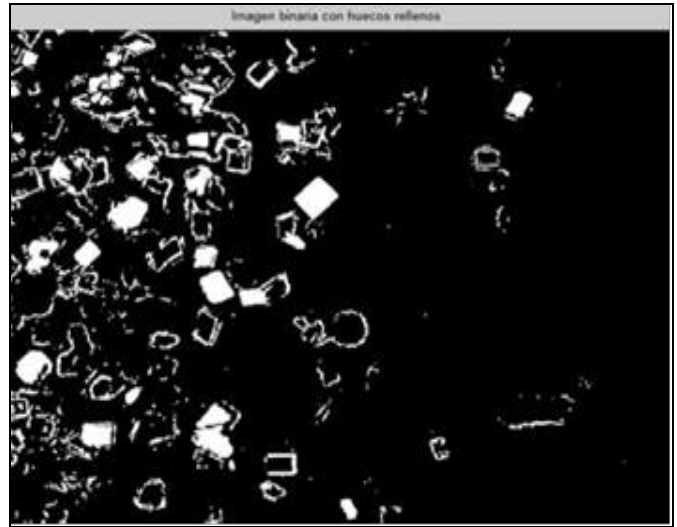
Figura 11: Imagen Rellenada. Fuente: Los autores,